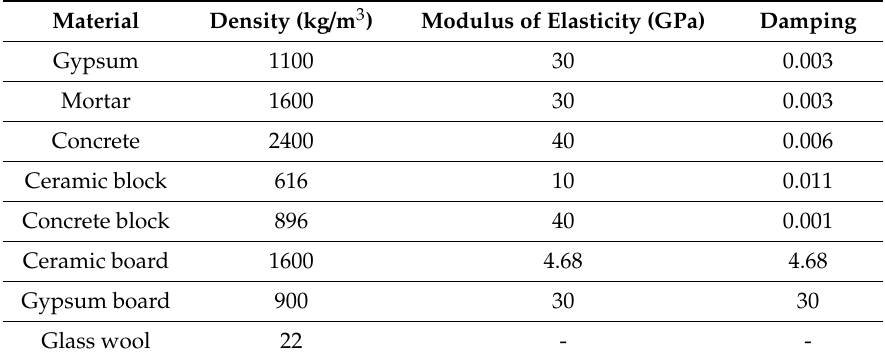
Table 15. Properties of materials used for modeling in Insul [28] / Engineering noise control—Theory and Practice [33].